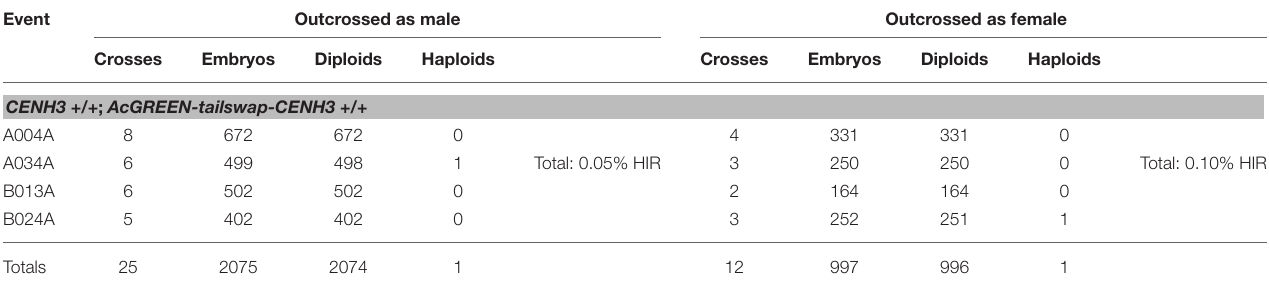
TABLE 1 | Haploid induction frequency determination in control ( CENH3 +/+ ) lines complemented by two copies of the AcGREEN-tailswap-CENH3 transgene. Event Outcrossed as male Outcrossed as female Crosses Embryos Diploids Haploids Crosses Embryos Diploids Haploids